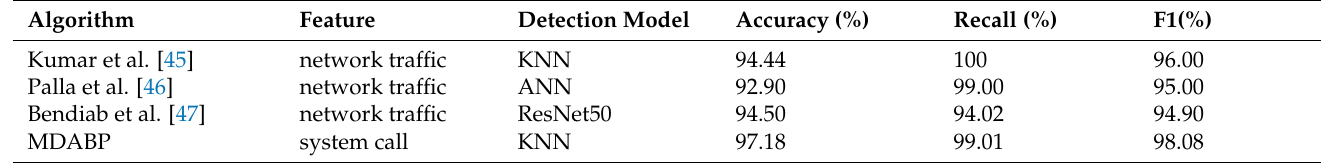
Table 4. Comparison of MDABP against existing malware classification